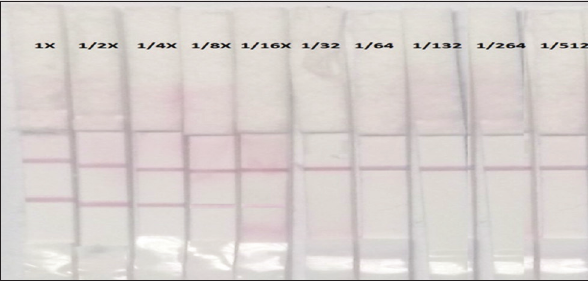
Figure-2: Sensitivity test of Salmonella Enteritidis-lateral flow immunochromatographic test.